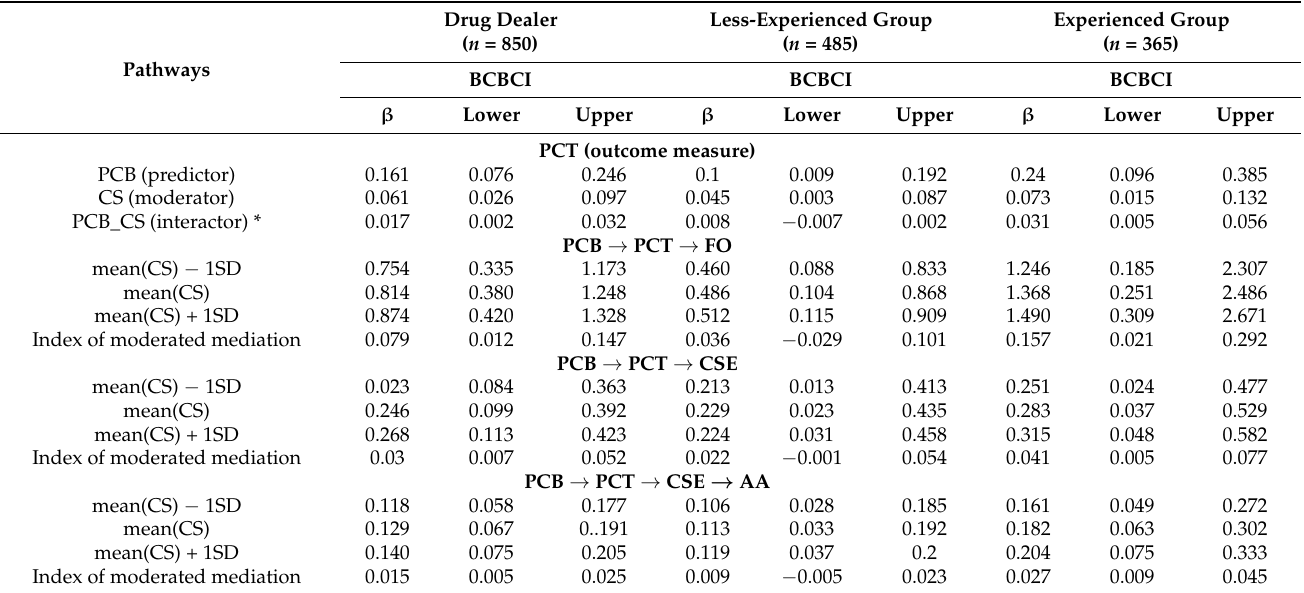
Table 4. Moderatedmediation analysisof perceivedcrime benefitas apredictorof future offending, criminal self-efficacy, and arrest avoidance via proactive criminal thinking when moderated by crime strategy.